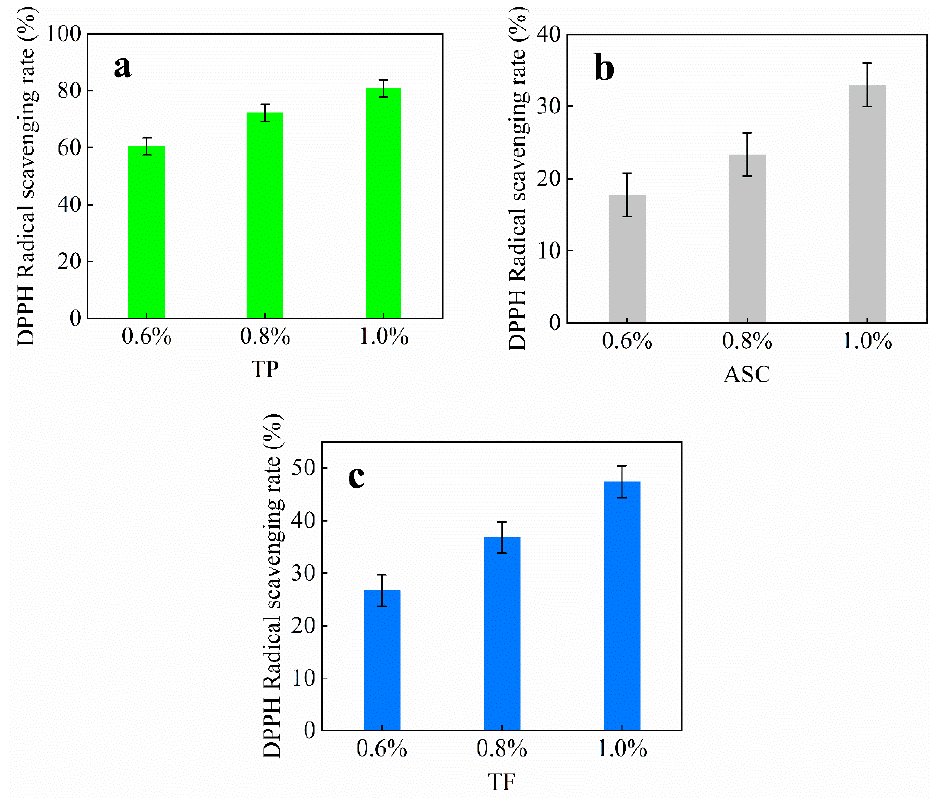
Figure 5. Effect of natural antioxidant species on the DPPH radical-scavenging rate of citral. ( a ): the DPPH radical scavenging rate of tea polyphenols; ( b ): the DPPH radical scavenging rate of ascorbic acid; ( c ): the DPPH radical scavenging rate of theaflavins.